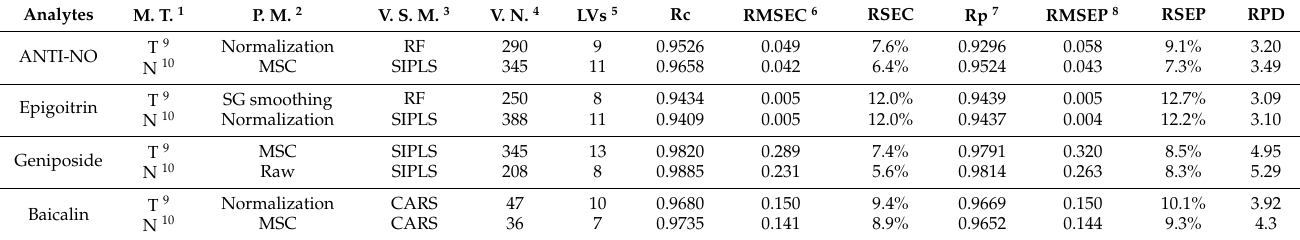
Table 5. The optimal PLSR model of 4